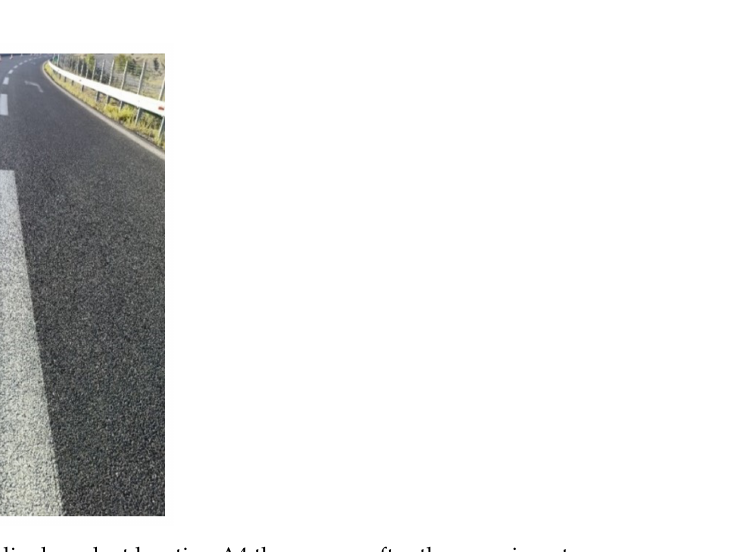
Figure 16. Longitudinal crack at location A4 three years after the